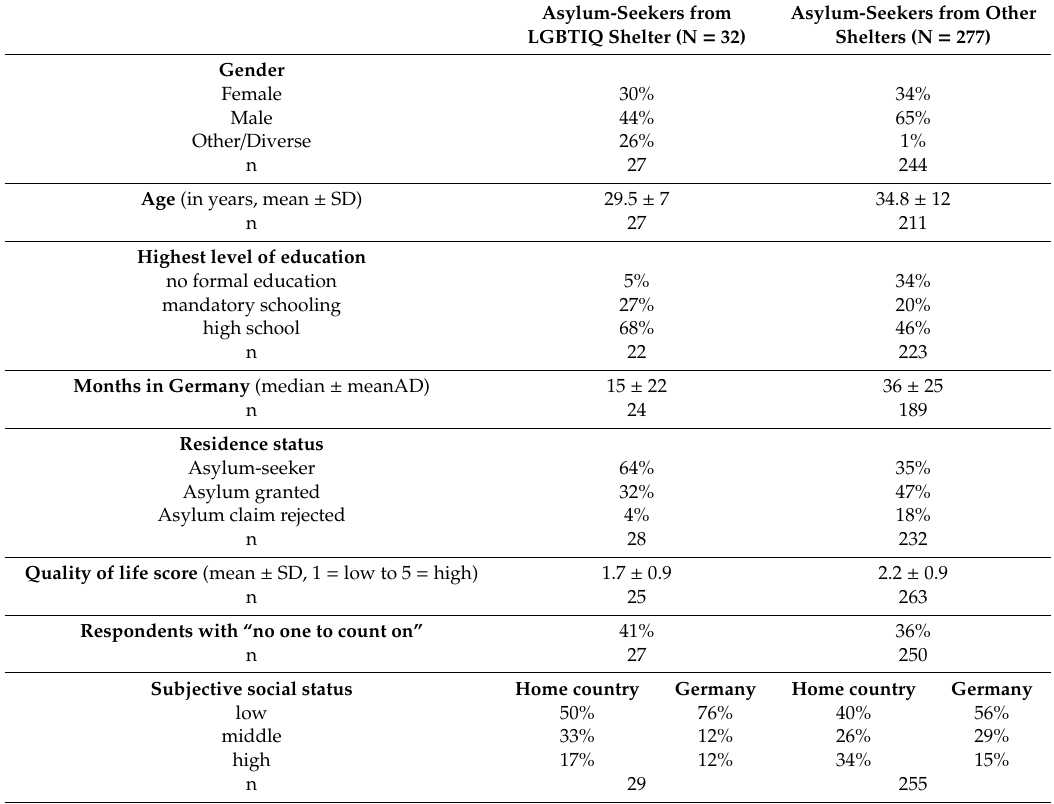
Table 1. Sociodemographic characteristics and social determinants of